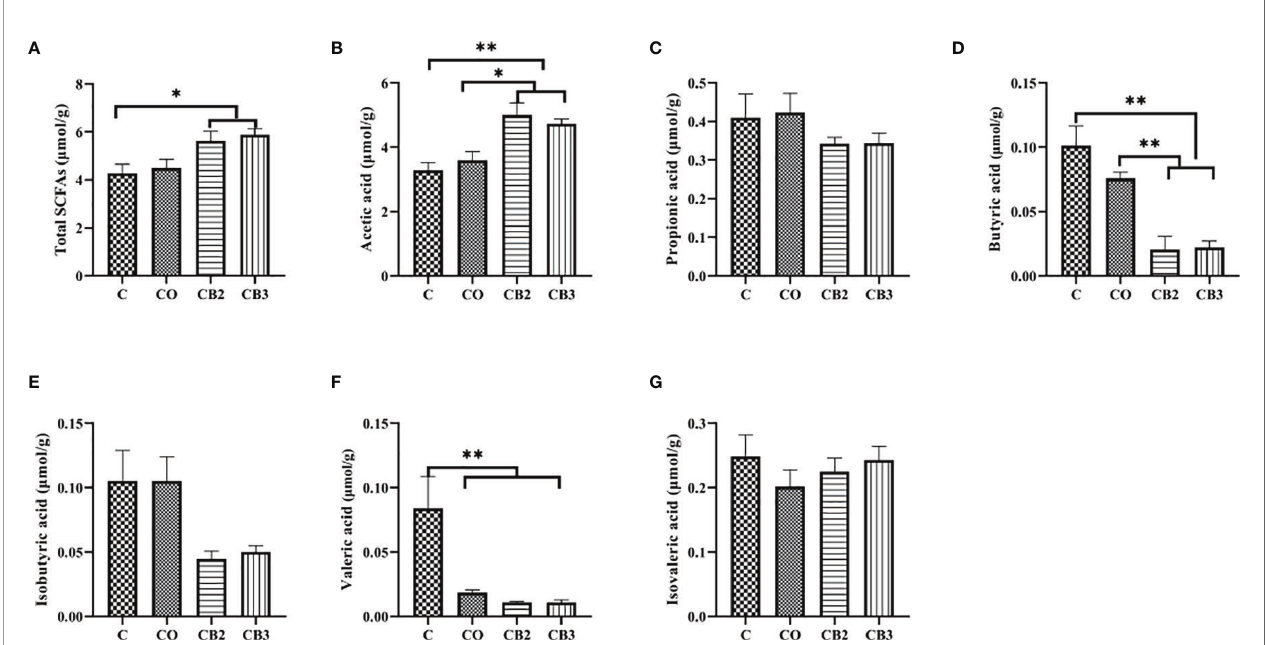
FIGURE 7 | Effects of dietary chitosan oligosaccharides (COS) and Clostridium butyricum synbiotic supplementation on the concentrations of short-chain fatty acids (SCFAs) in ileum content of early-weaned pigeon squabs. (A) Total SCFAs. (B) Acetic acid. (C) Propionic acid. (D) Butyric acid. (E) Isobutyric acid. (F) Valeric acid. (G) Isovaleric acid. Values are means with the SEM of eight squabs. * p < 0.05 and ** p < 0.01. C group, control group, squabs fed with arti fi cial crop milk; CO group, squabs fed with arti fi cial crop milk + 150 mg/kg COS; CB2 group, squabs fed with arti fi cial crop milk + 150 mg/kg COS + 300 mg/kg C. butyricum